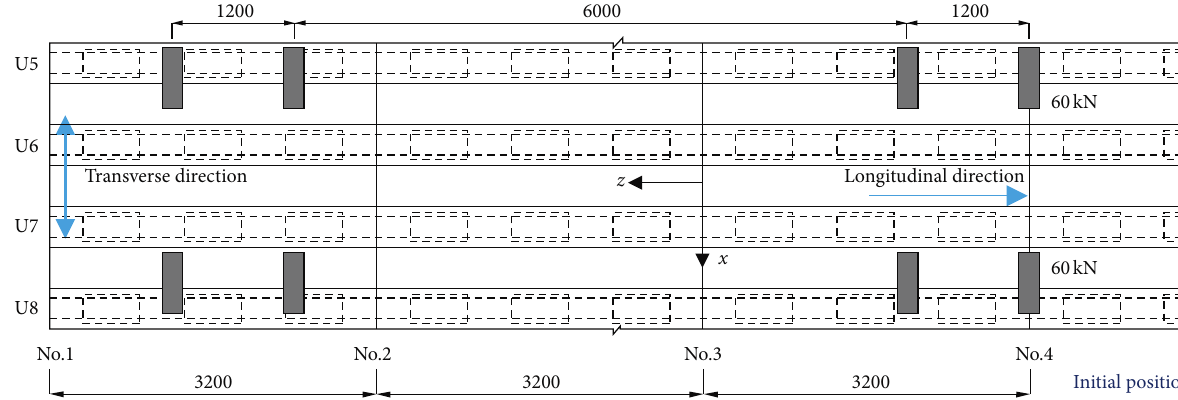
Figure 10: Wheel load moving direction (unit: